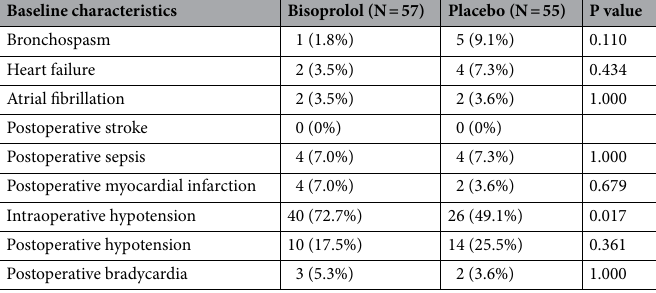
Table 3. Adverse events in bisoprolol and placebo